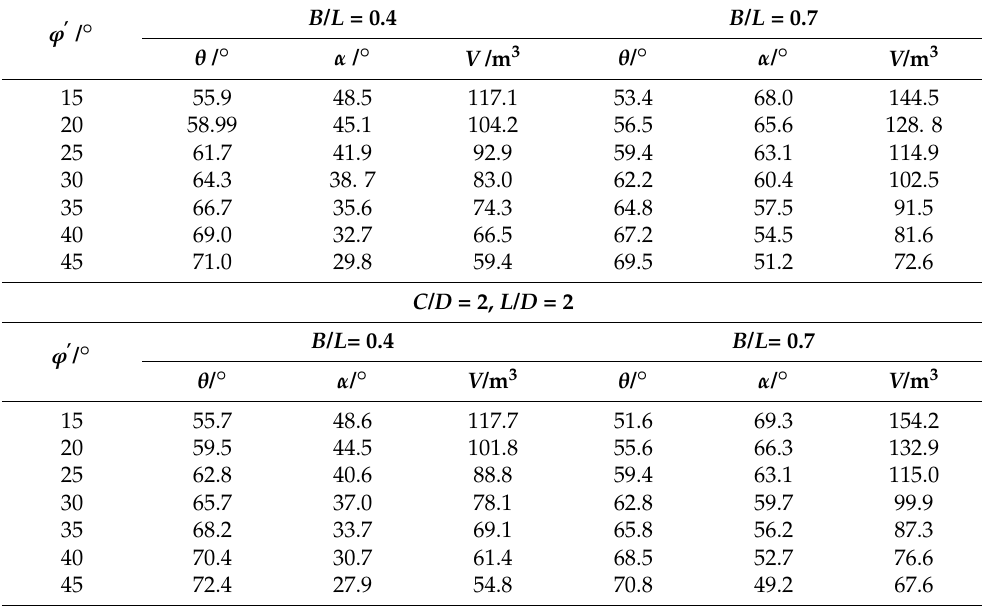
Table 3. Variations in the optimal θ , α , and V depending on ϕ (cid:48) . ϕ ’ /